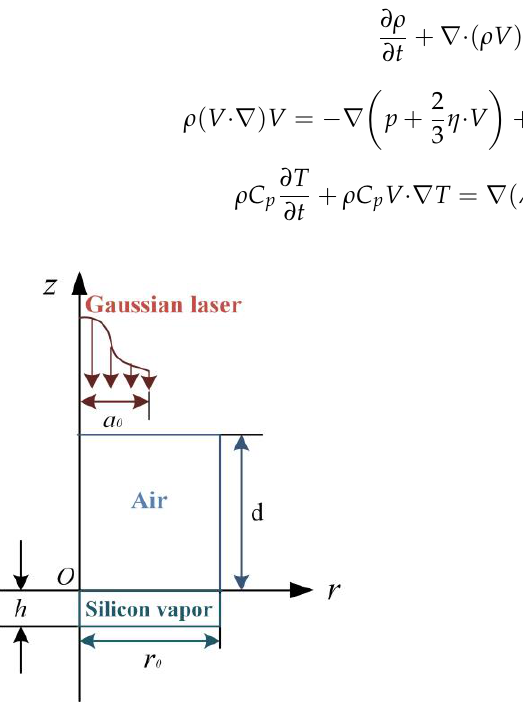
Figure 5. 2D calculation model. Table 2. The main physical